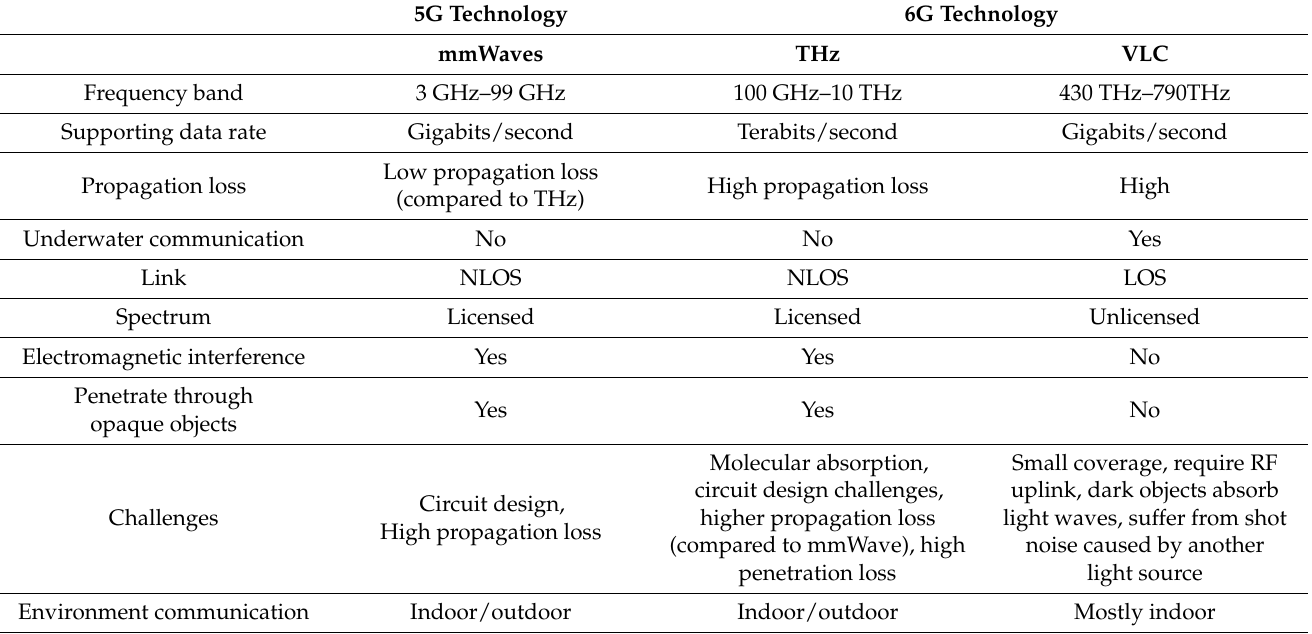
Table 2. Comparison of 5G (mmWaves) and 6G (THz and VLC) technologies.